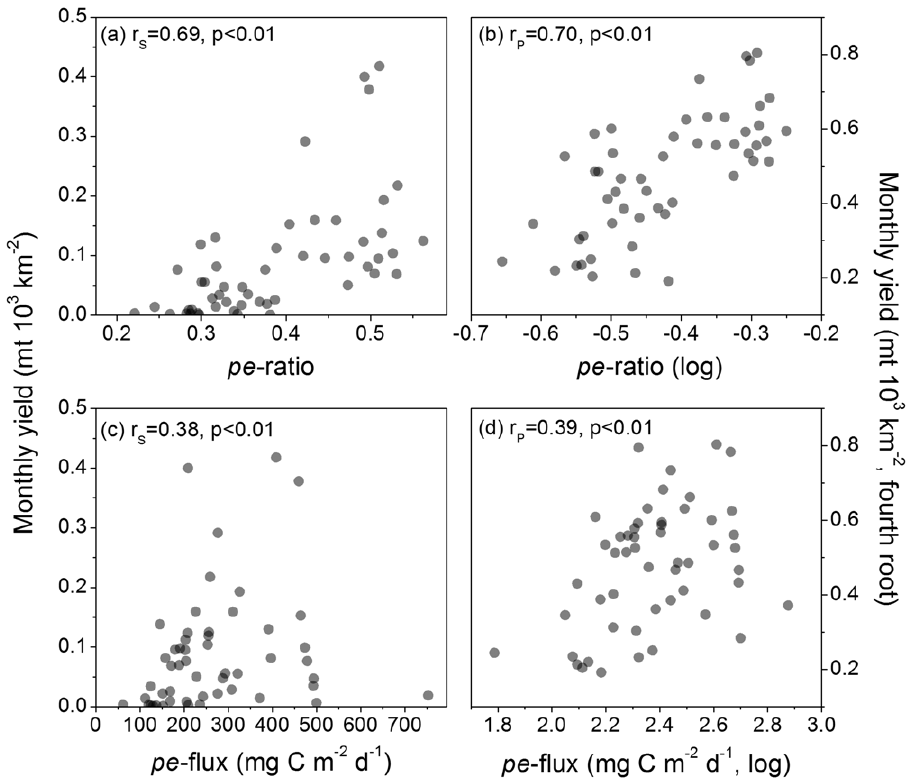
Figure 5. Fishery yield versus particle export ratio and particle export flux. Scattergrams of: (a) total monthly fishery yield and pe -ratio; (b) same data as panel (a) transformed to approximate bivariate normality; (c) total monthly fishery yield and pe -flux computed using the Eppley -VGPM algorithm; and (d) same data as panel (c) transformed to approximate bivariate normality. N=52, the total number of LMEs in the analysis, for all plots. r S =Spearman rank-order correlation and r P =Pearson product-moment correlation.